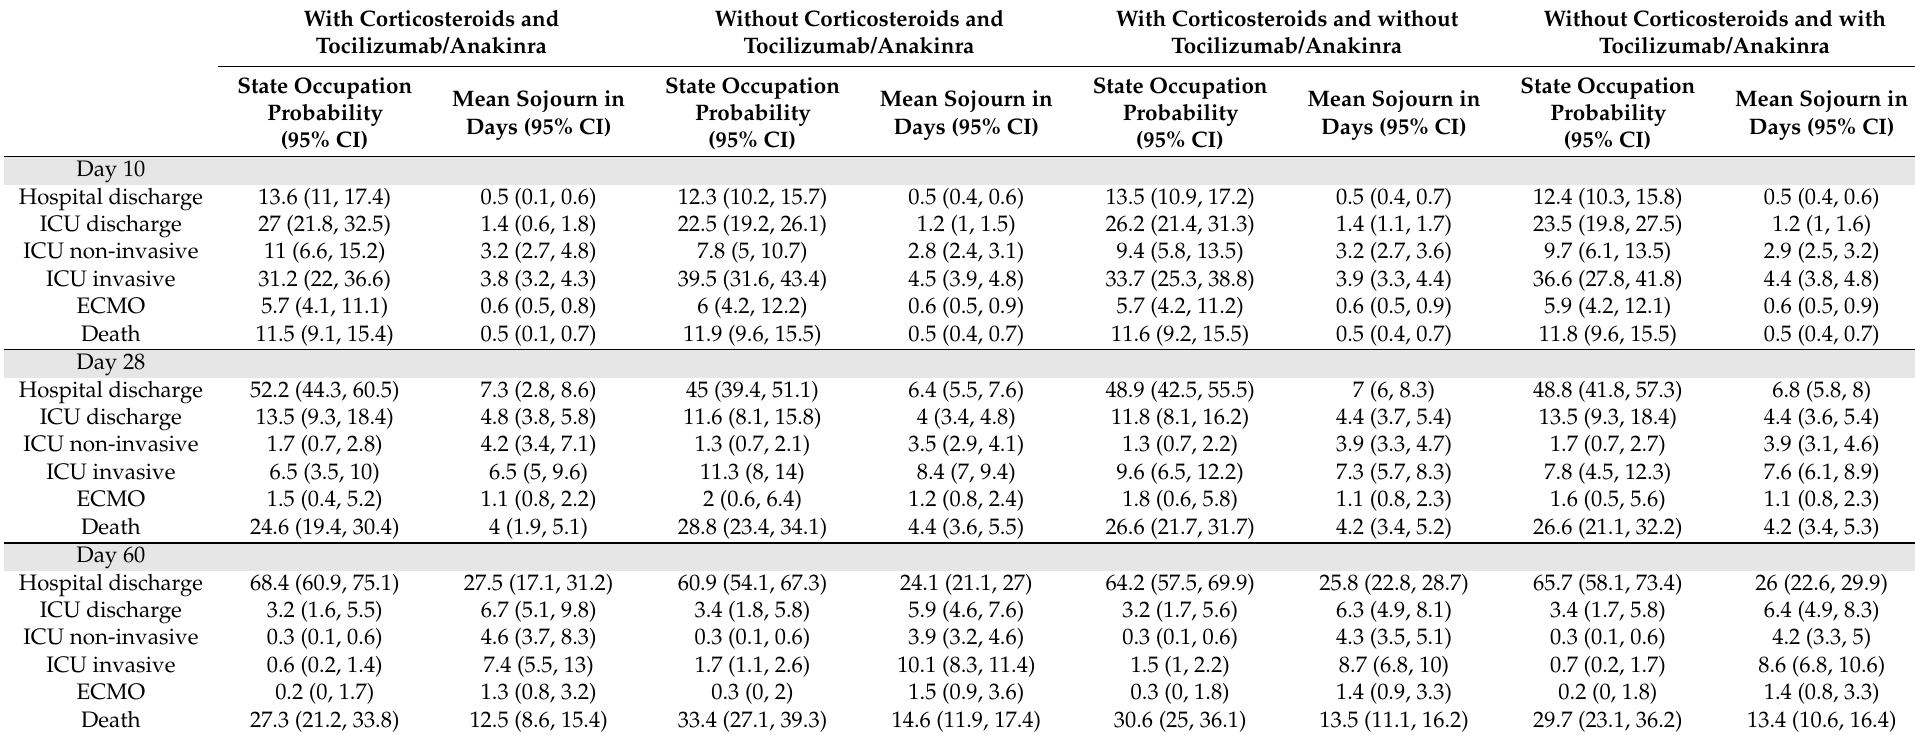
Table 3. State occupancy probability and mean sojourn time resulting from the G-computation. With Corticosteroids and Without Corticosteroids Tocilizumab/Anakinra